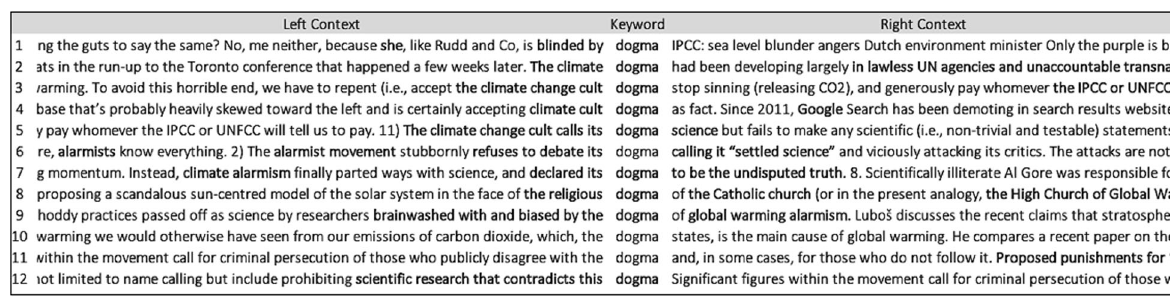
Fig. 5 Concordance lines ( dogma ) extracted from CSBC-CON and ordered alphabetically by the word in position 1 to the